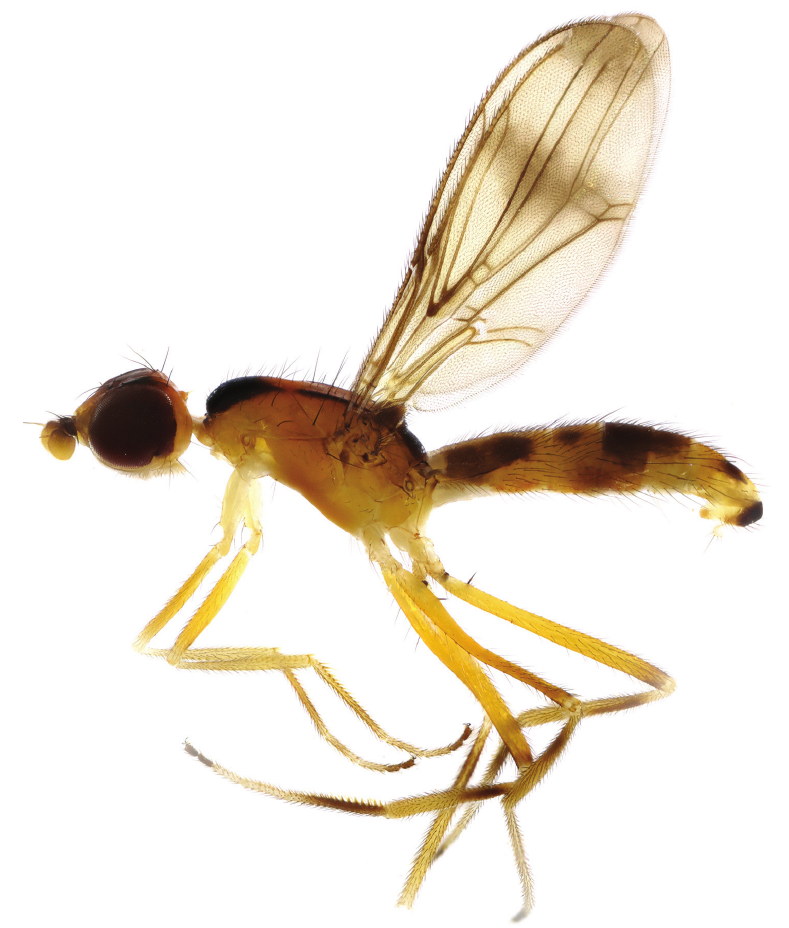
Figure 6. Strongylophthalmyia orchidanthae sp. n. Habitus, lateral view. shorter than distal section. Posterior basal cell approximately 0.6 times shorter than discal cell. Calypter yellowish with fan of very long yellow setulae on margin. Halter with yellow stem and whitish knob. Chaetotaxy: one very small postpronotal seta, one dorsocentral seta, two notopleural setae, one supraalar seta, one postalar seta, one anepisternal seta, one stout apical scutellar seta. Abdomen yellow, tergite 1–2 with pair of black longitudinal stripes, tergite 3 with pair of light brown median spots, tergite 4 with large black triangular spot, tergite 5 with narrow dorsal band on anterior ¾. Sternite 8 large, situated on dorsal side, with large black spot. Epandrium yellow apically, brown basally. Body length 4.3 mm; wing length 3.1 mm. Female unknown Etymology. The new species was collected on Orchidantha